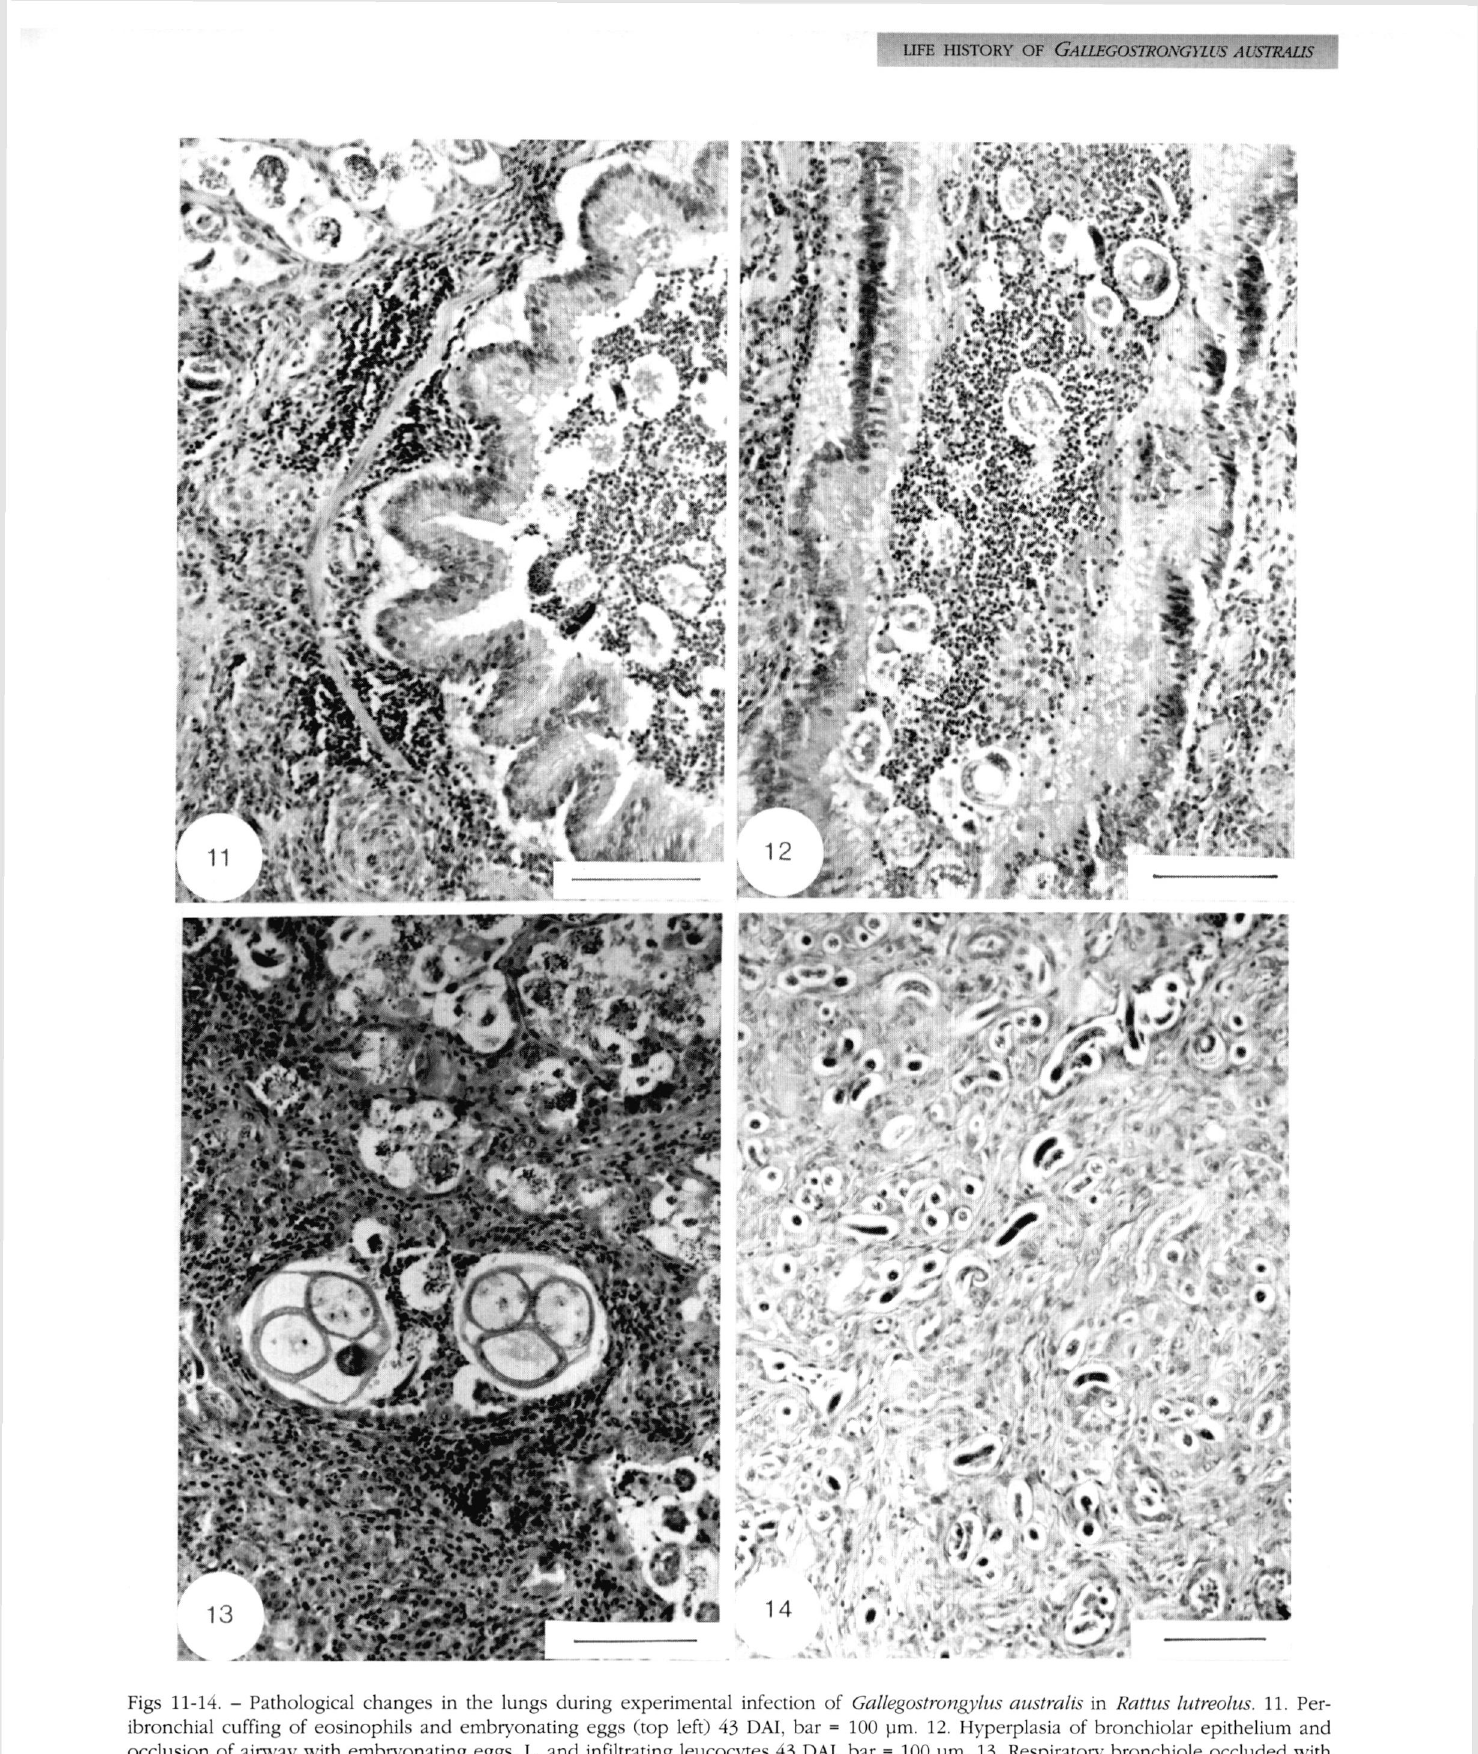
Figs 11-14. - Pathological changes in the lungs during experimental infection of Gallegostrongylus australis in Rattus lutreolus. 11. Per­ ibronchial cuffing of eosinophils and embryonating eggs (top left) 43 DAI, bar = 100 um. 12. Hyperplasia of bronchiolar epithelium and occlusion of airway with embryonating eggs, L, and infiltrating leucocytes 43 DAI, bar - 100 um. 13. Respiratory bronchiole occluded with adult nematode and numerous eosinophils, surrounding embryonated eggs and L, in alveolar sacs 60 DAI, bar = 100 pm. 14. Embryonated eggs and L, trapped in fibrous connective tissue 114 DAI, bar = 100